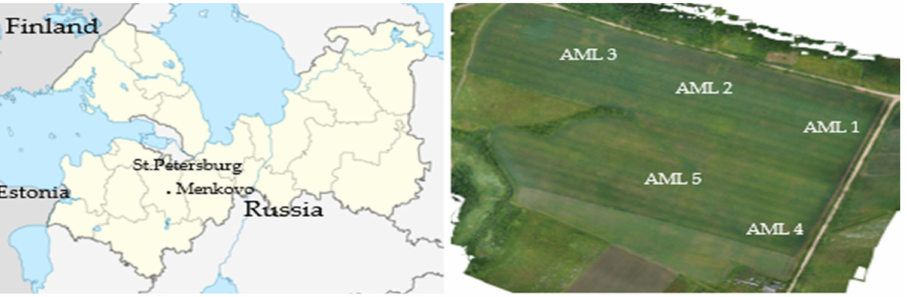
Figure 1. Location of the study (AML 1–5 are agricultural microlandscapes 1–5 within the land- scape